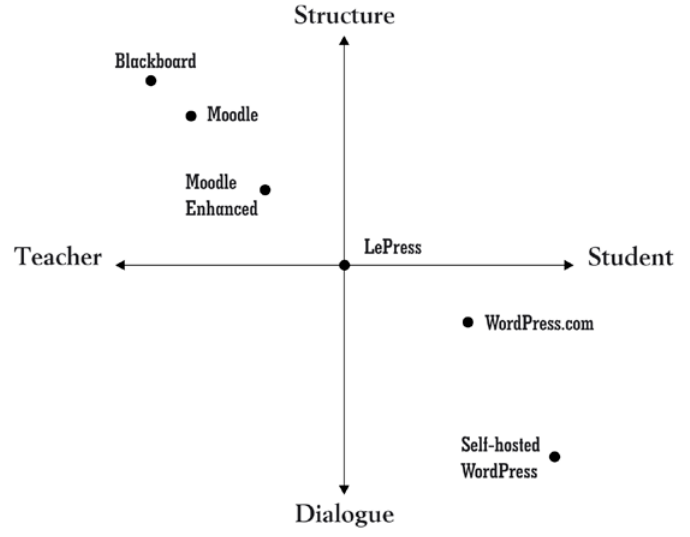
Figure 4. Speculative distribution of control over learning flows between the teacher and the student in different learning